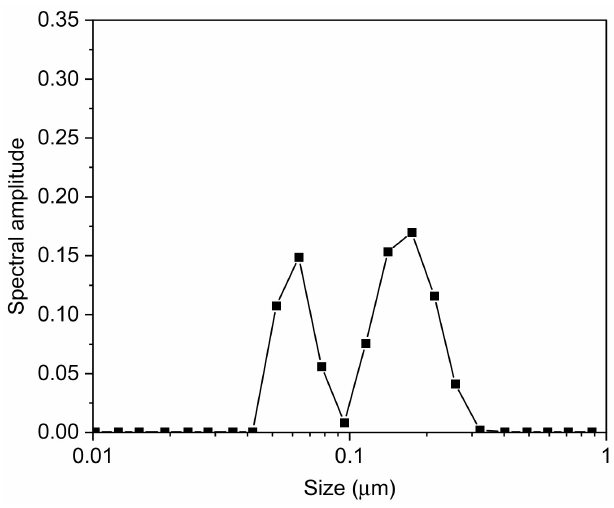
Figure 1. Dimensional analysis of CS/TPP-HY